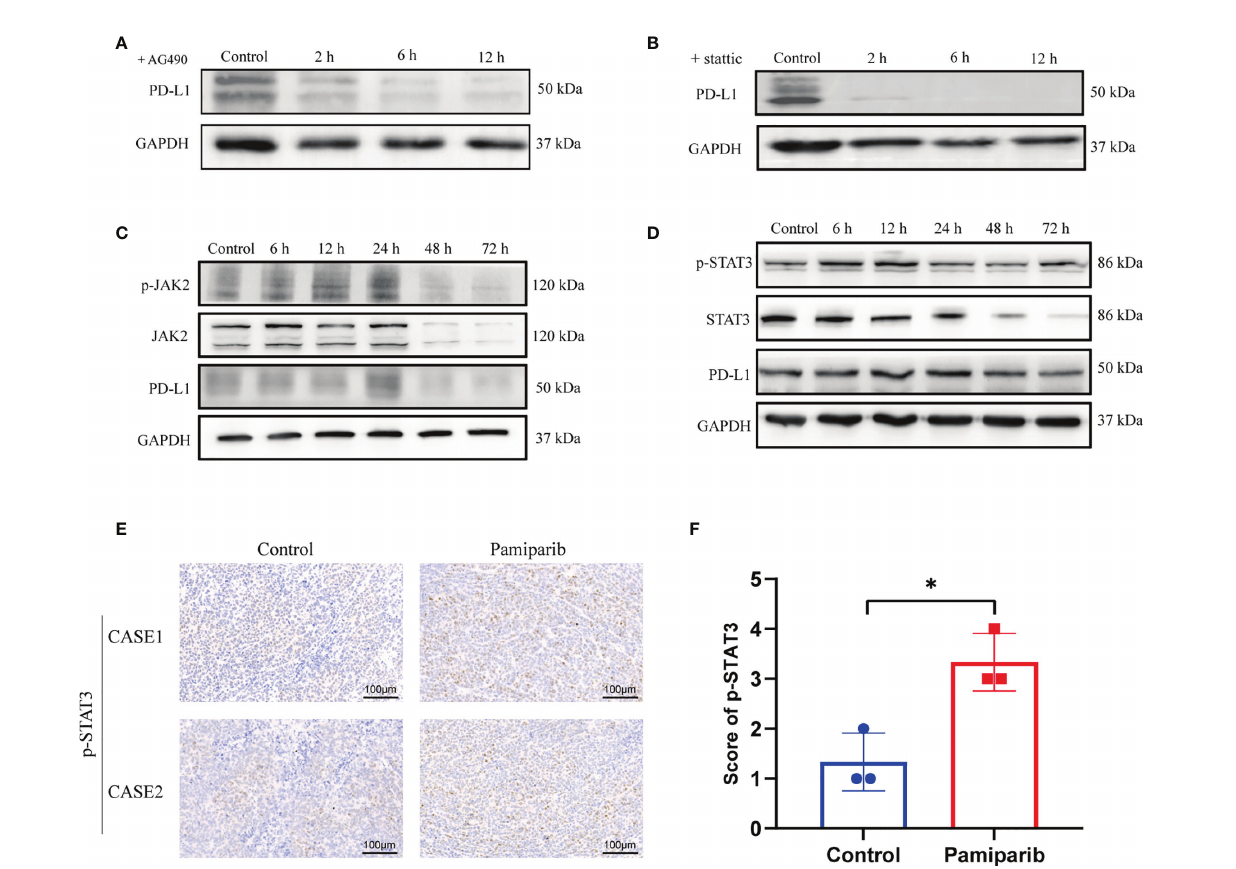
FIGURE 4 | Pamiparib treatment induces PD-L1 expression via JAK2/STAT3 pathway. (A) Cells were pretreated with pamiparib (100 m M, 12h) and PD-L1 expression was assessed by immunoblotting after treatment with the concentrations (20 m M) of AG490 for 24h. (B) Cells were pretreated with pamiparib (100 m M, 12h) and PD-L1 expression was assessed by protein blotting after treatment with stattic (20 m M) for 24h. (C) Protein expression of phospho-JAK2 (p-JAK2), JAK2, and PD-L1 in SW1990 cells after being treated with pamiparib (100 m M) for the indicated times. (D) Protein expression of phospho-STAT3(p-STAT3), STAT3 and PD-L1 in SW1990 cells after being treated with pamiparib (100 m M) for the indicated times. GAPDH was used as a loading control. (E) IHC staining of p-STAT3 of nude mouse xenograft tumors in control group and treated with pamiparib group. Scale bar, 100 m m. (F) IHC staining score showed the expression of p-STAT3 was signi fi cantly upregulated in nude mice pamiparib treated group. Data are mean ± SD; n = 3 samples per group. The IHC results were analyzed by Pearson c 2 test. * P <